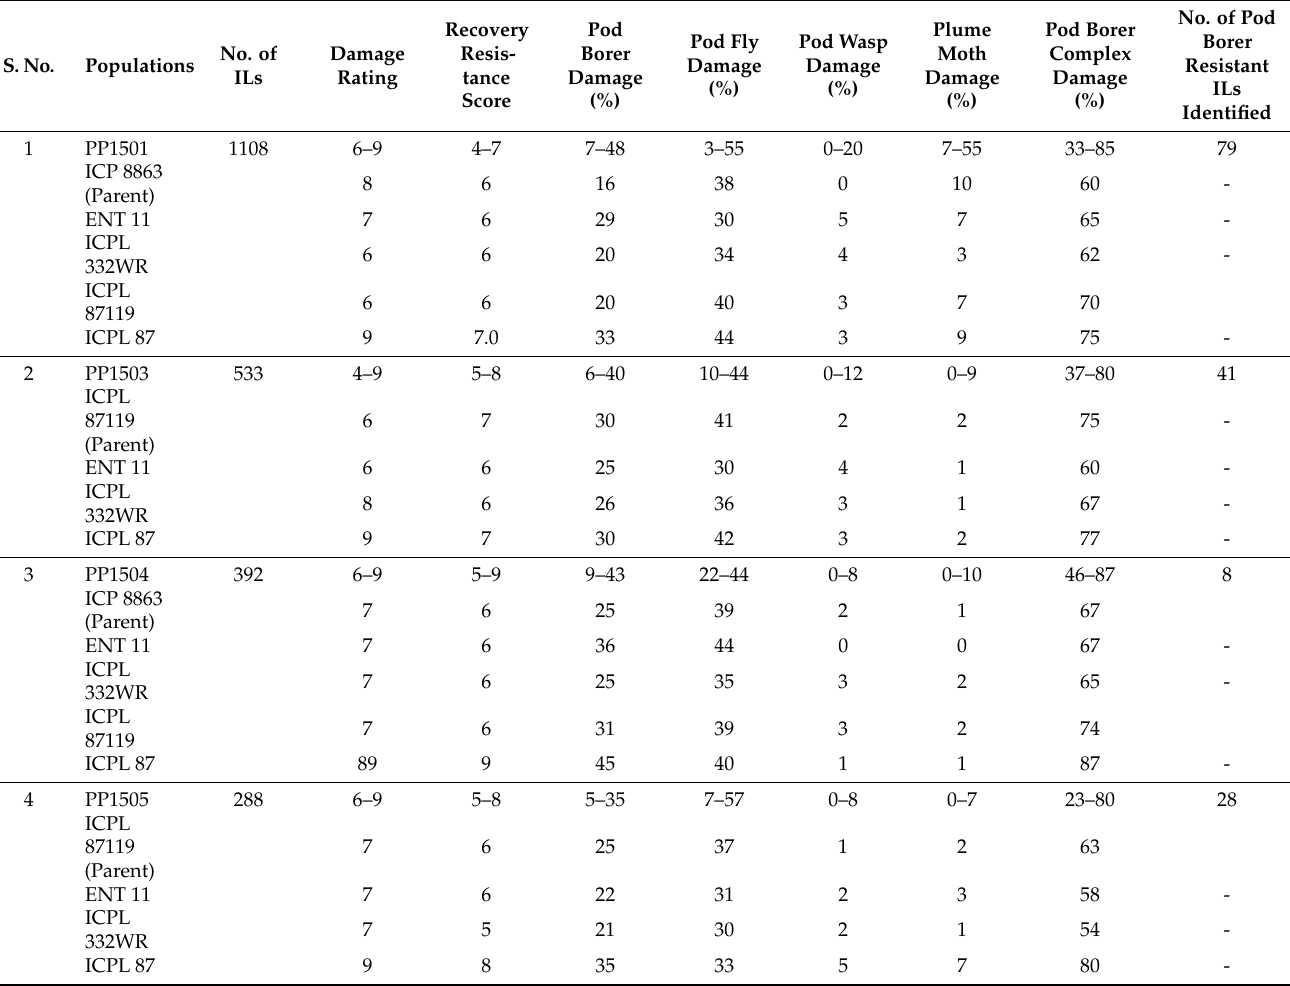
Table 2. Evaluation of four pre-breeding populations derived from wild Cajanus species for resistance to pod borer complex during 2018 rainy season at ICRISAT, Patancheru, India. ILs, introgression lines.